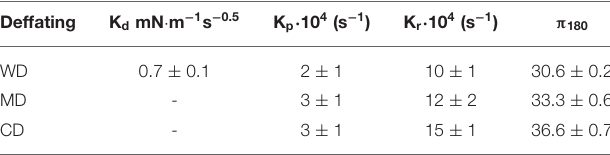
TABLE 3 | Kinetic parameters of protein adsorption at different quinoa concentrations at the air/water interface.